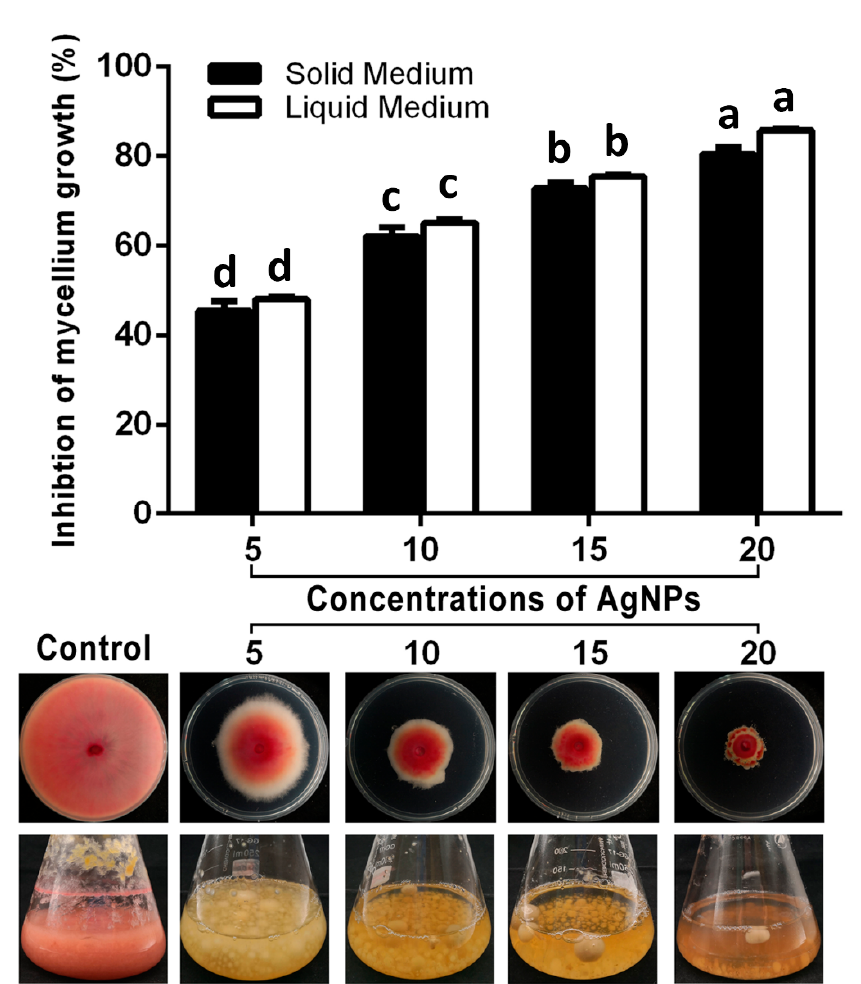
Figure 2. In vitro antifungal activity of AgNP biosynthesis at different concentrations against Fusarium graminearum strain PH − 1 in potato dextrose agar (PDA) and potato dextrose broth (PDB) mediums. *Data are a mean value ± standard error of three replicates, and bars with the same letters are significantly different in LSD test ( p < 0.05).